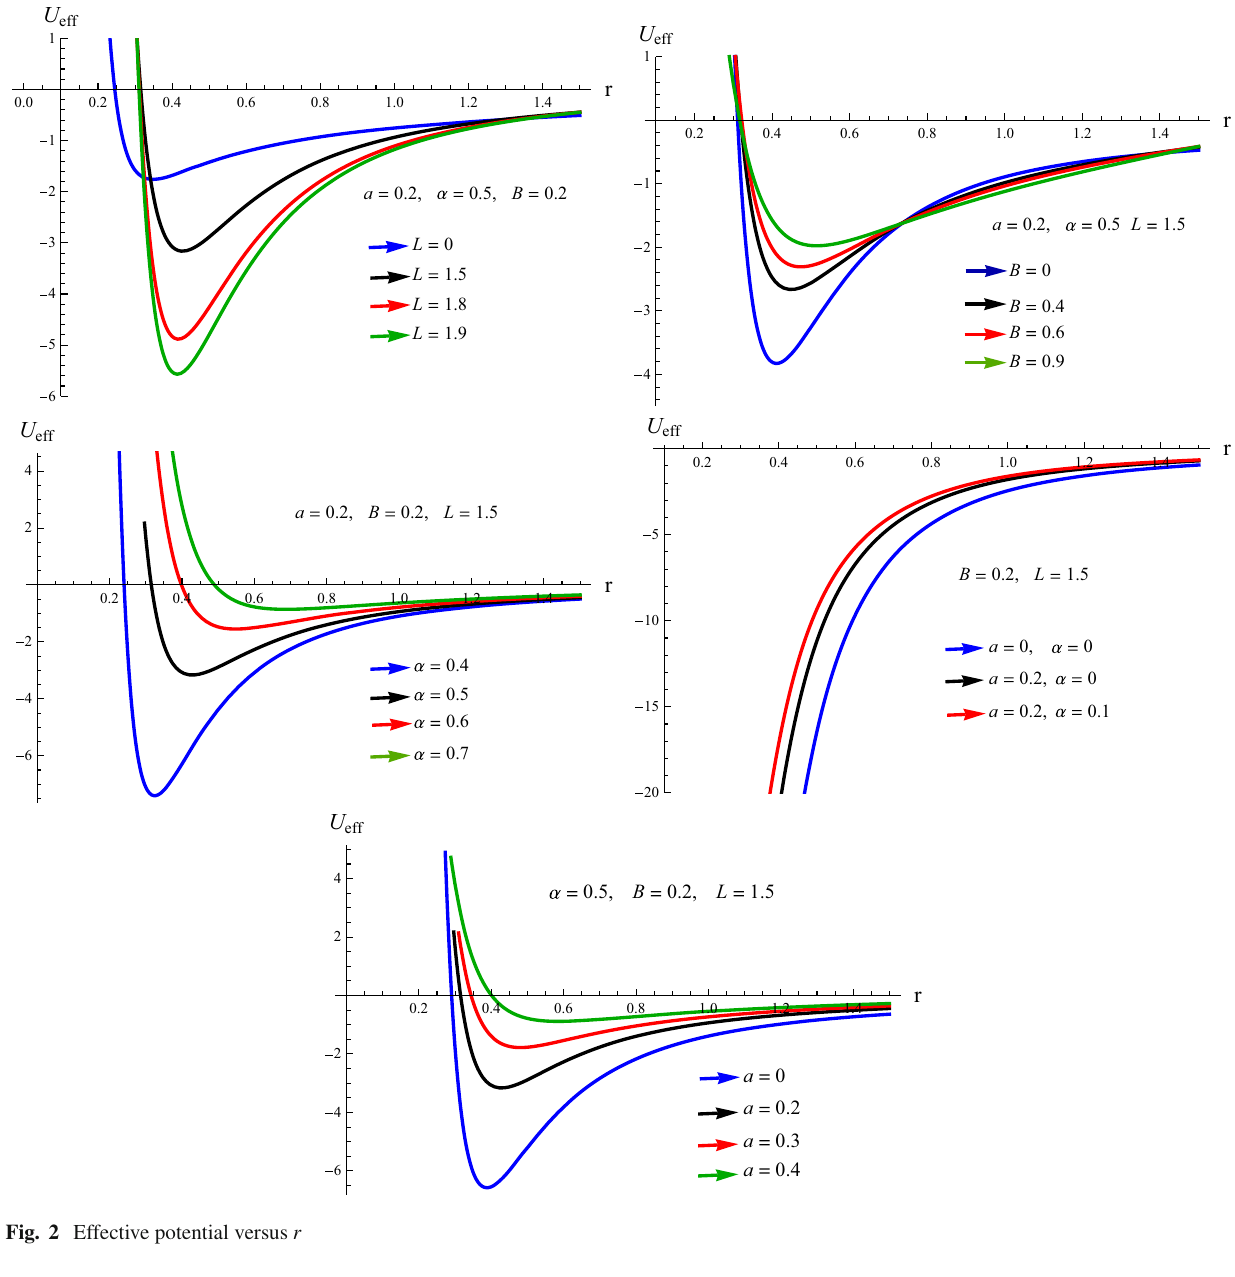
Fig. 2 Effective potential versus r